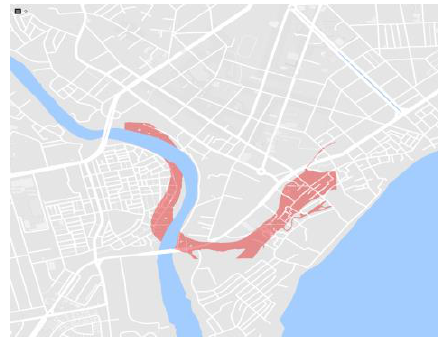
Figure 15. Red - original path of Davao River. Blue - Current Davao River meander in Google